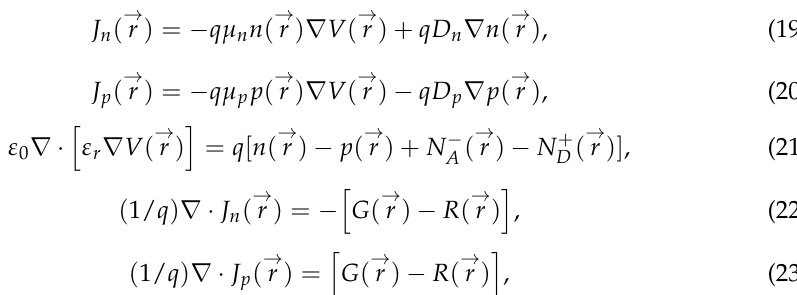
solution of the drift-diffusion model, which is expressed as [24]